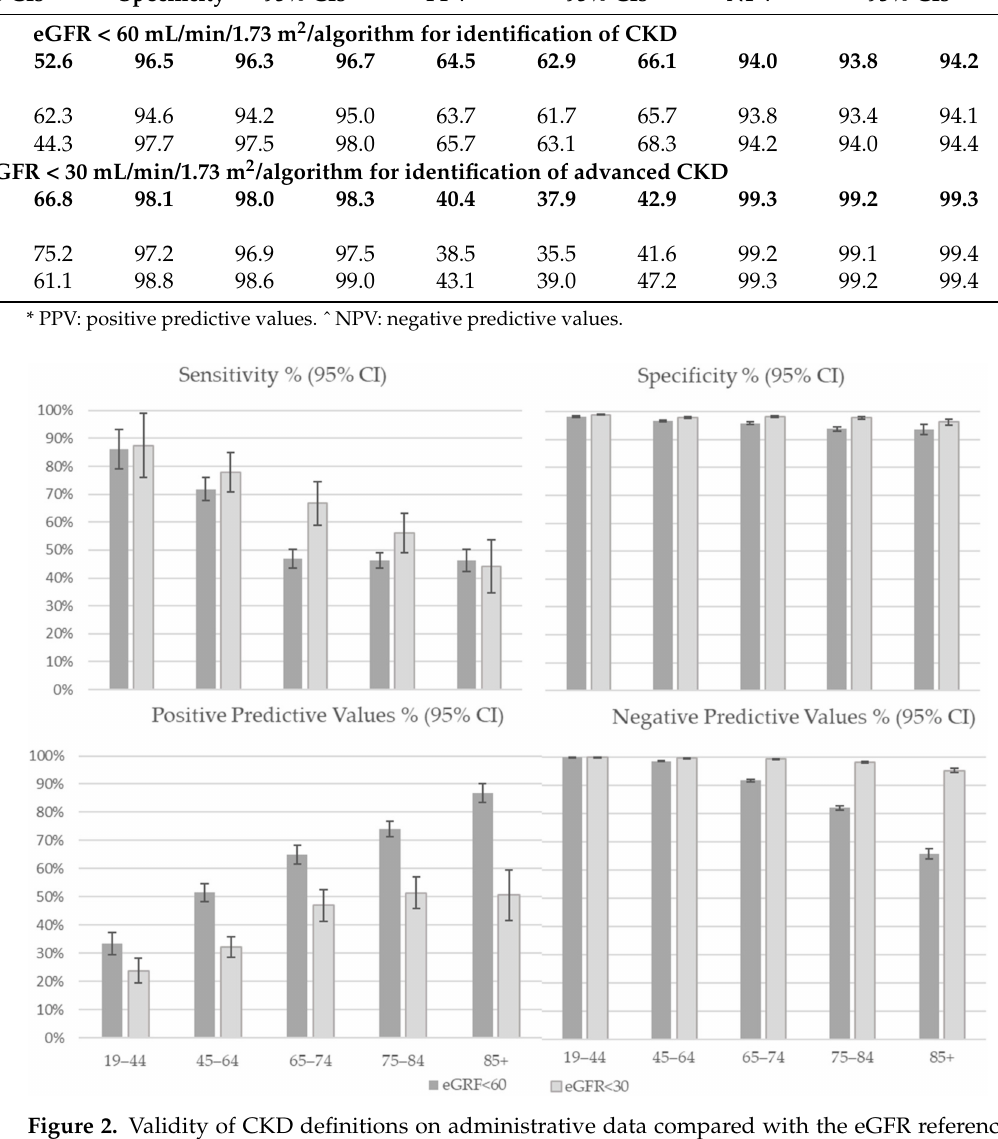
Figure 2. Validity of CKD definitions on administrative data compared with the eGFR reference standard, by age